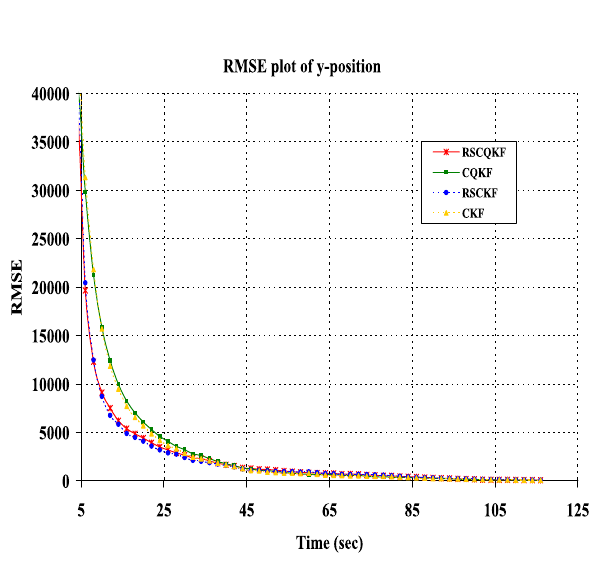
Fig. 6 RMSE plot of RSCQKF, RSCKF, CQKF and CKF for 𝐱 -position (in km) of the target